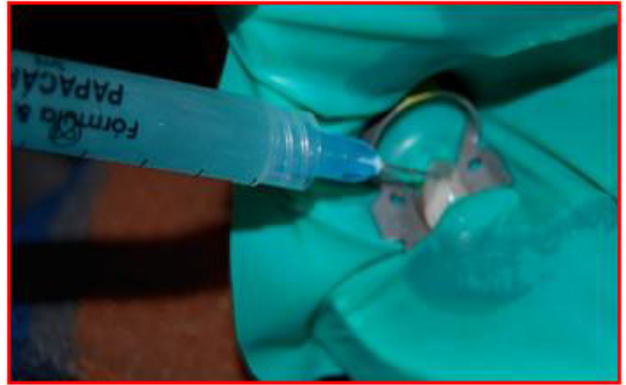
Fig. 3 - Caries removal using the chemomechanical caries removal agent Papacarie ®